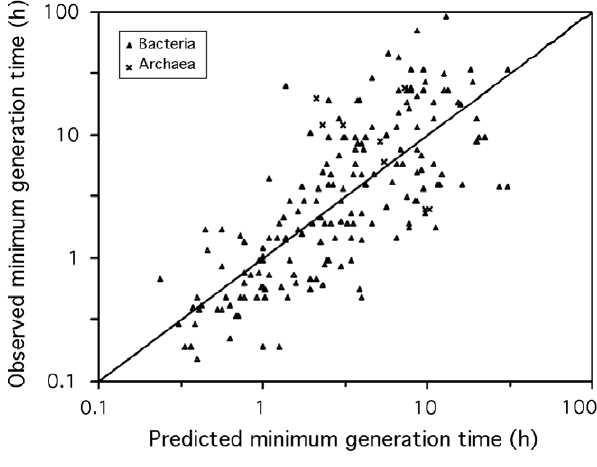
Figure 5. Observed versus predicted minimum generation time. The mesophilic predictor based on codon usage bias (eq. 3) was applied to the 187 mesophilic prokaryotic genomes. The diagonal black line corresponds to the identity.